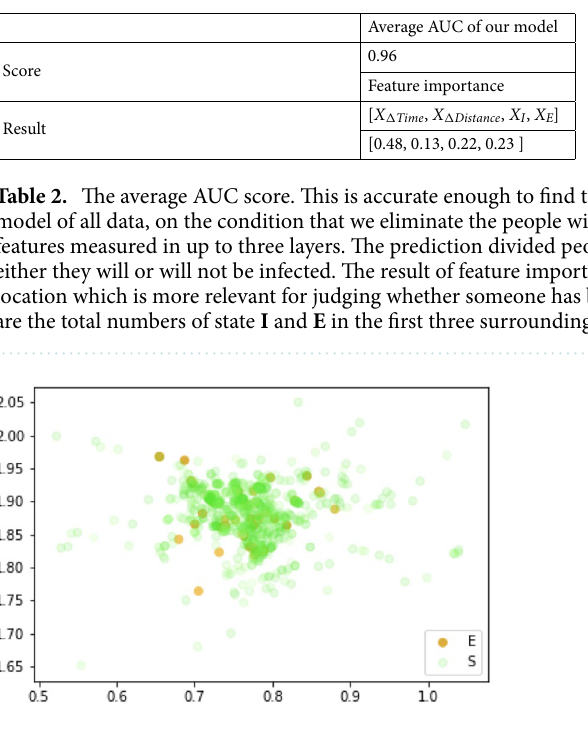
Figure 5. City ranking overview. The x_axis is the longitude, and the y_axis is the latitude of the position. Then we illustrate the probability of all people of an S (Susceptible) and E (Exposed) state of ranking in the 8% proportion of the center of the city area by the intensity of the colors based on the last record of location from interaction data in Fig. 4.